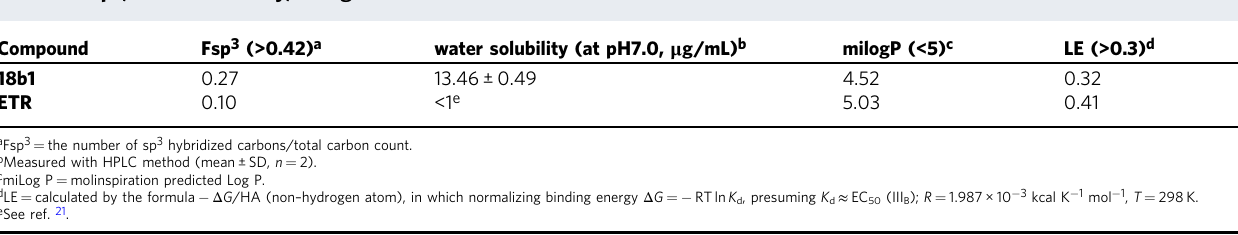
Table 5, 18b1 exhibited weak inhibitory activity against CYP2C9 (IC 50 = 5.30 μ M) and CYP2C19 (IC 50 = 8.00 μ M), while con- versely ETR (IC 50 = 0.277 μ M and 0.496 μ M, respectively) and RPV (IC 50 = 0.346 μ M and 0.335 μ M, respectively) were sub-